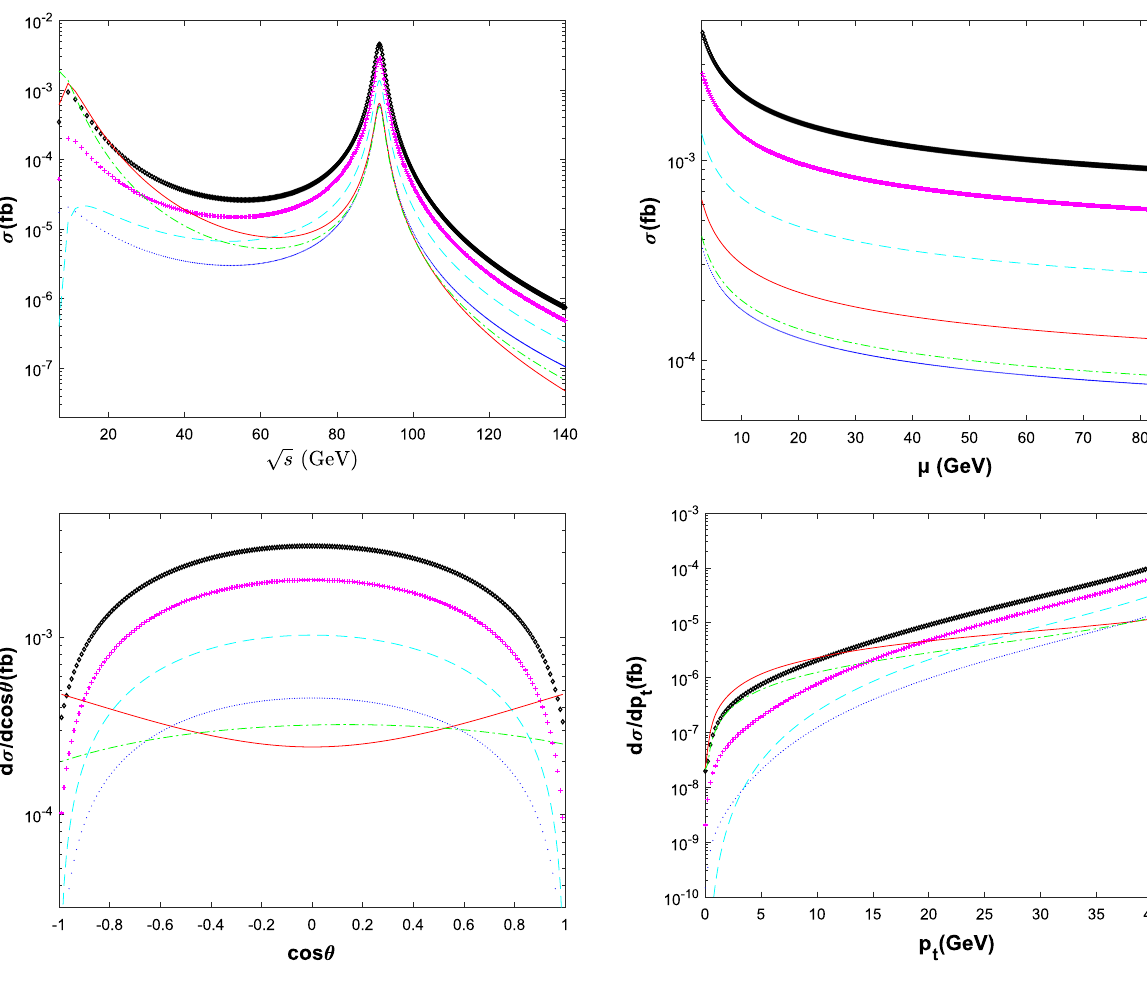
Fig. 2 Total cross sections versus the CM energy malization scale μ , the differential angle distributions d σ /dcos θ , and the p t distributions d σ /d p t at production. The diamond black line, cross magenta line, dashed cyan